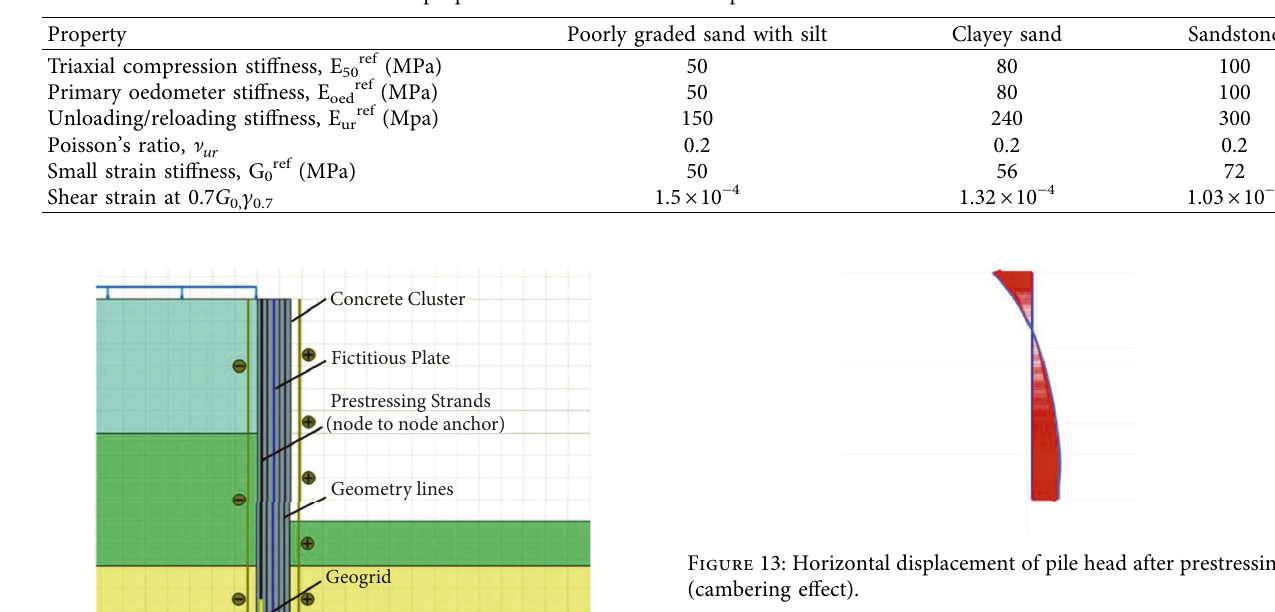
Table 4: Mechanical properties of of elastic and elastoplastic soil used for the HS small model.